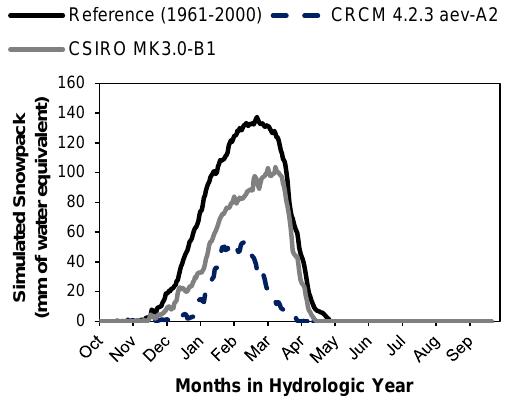
Fig. 8. ForHyM2-simulated snowpack depth (averaged over the du- ration of the simulation period) vs. the date. Simulated snowpack depths for the other five climate scenarios are within the range set by the CSIRO Mk3.0-B1 and CRCM 4.2.3 aev-A2 results.